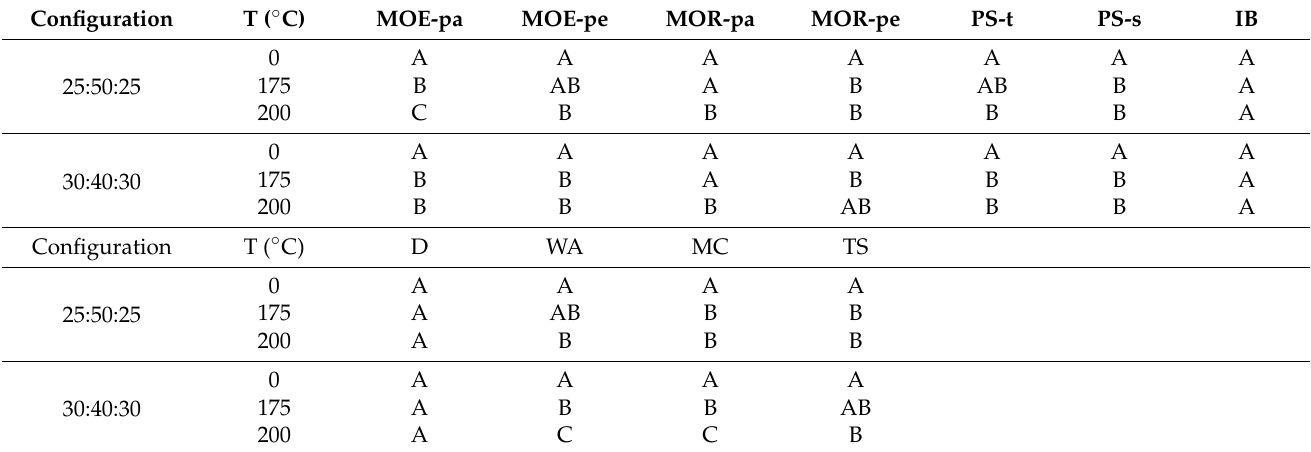
Table 3. Results of Tukey’s test on the influence of temperature (T).